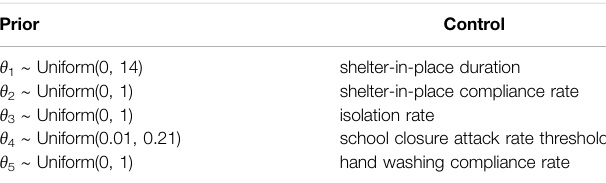
TABLE 1 | Prior over FRED control parameter θ (cid:1) ( θ 1 , ... , θ 5 ) for in fl uenza simulations. Prior Control θ ∼ Uniform(0, 1